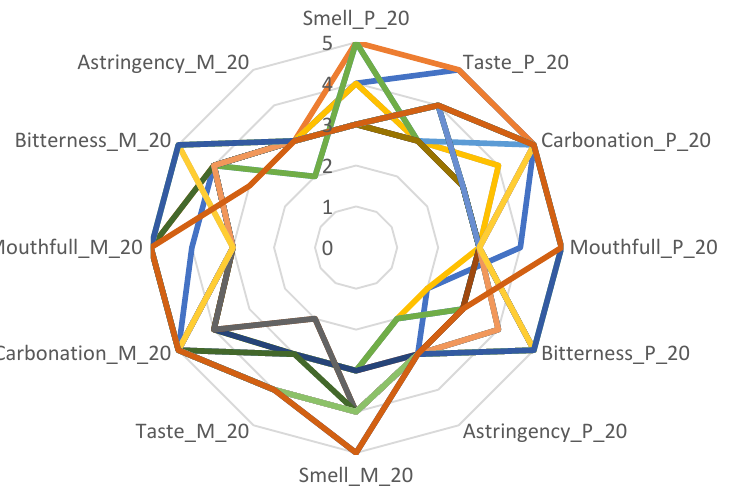
Figure 1. Sensory analysis of samples at 20 °C; Sample produced with pale ale malt is marked as “P” and sample produced with Munich malt is marked with “M”.